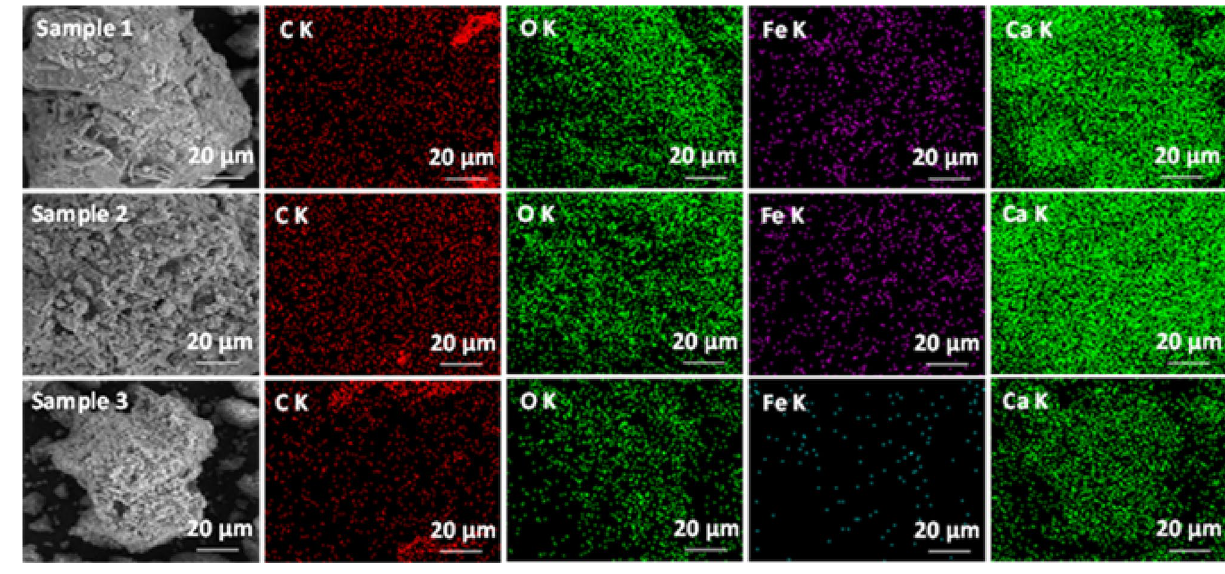
Figure 3. EDX elemental map of slag